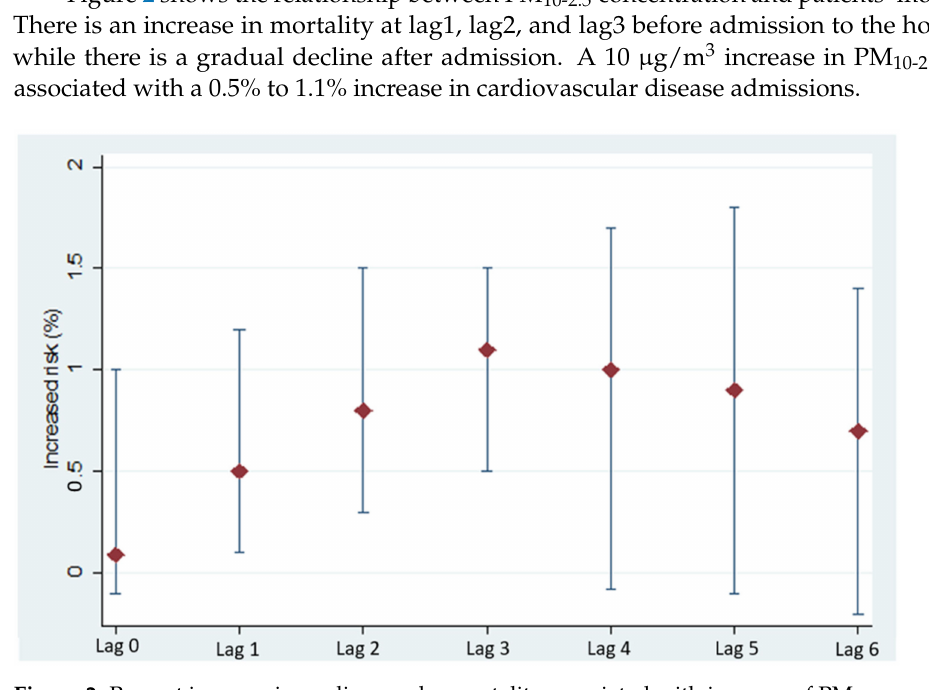
Figure 2. Percent increase in cardiovascular mortality associated with increase of PM 2.5